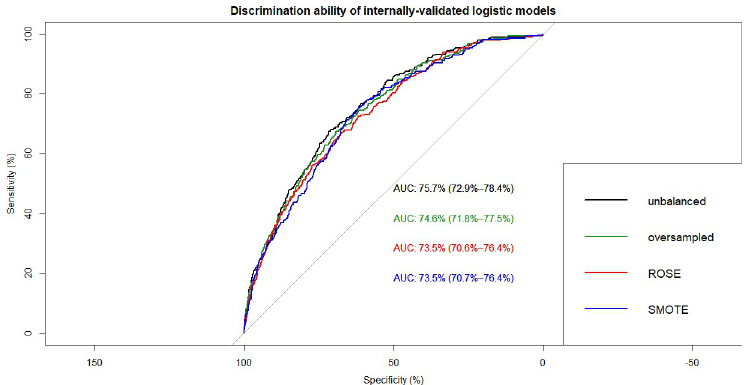
Fig 2. Overlapped ROC curves demonstrating predictive performance of logistic regression models on internal validation data. Using unbalanced, original training data and re-structured with oversampling, ROSE and SMOTE resampling.